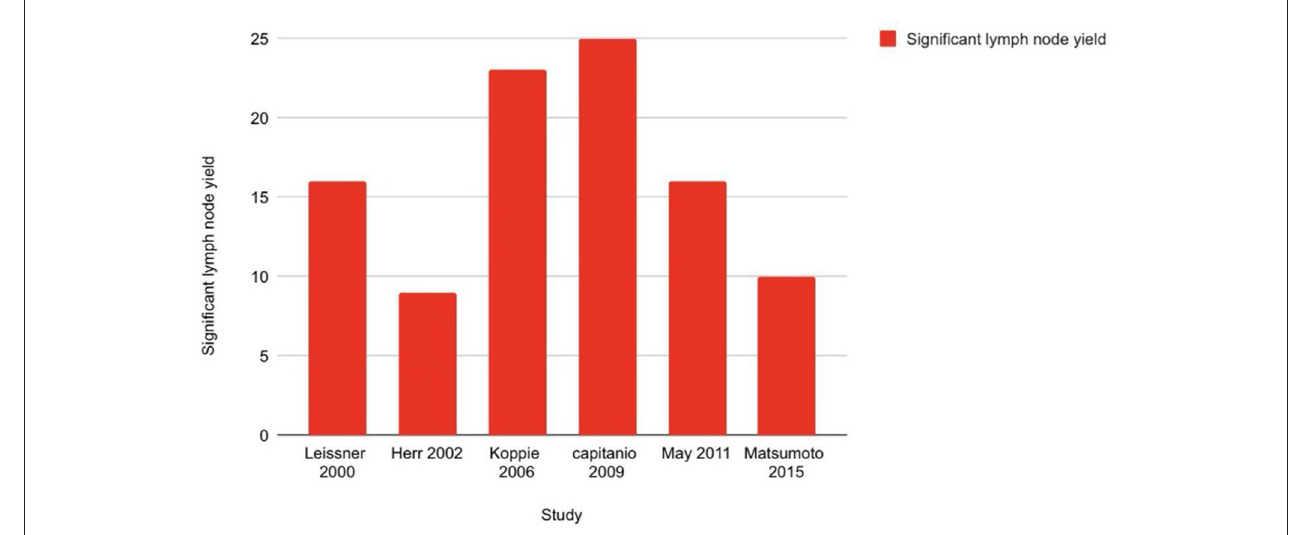
FIGURE 5 | Bar diagram showing minimum lymph node yield to be predictive of outcome of urinary bladder